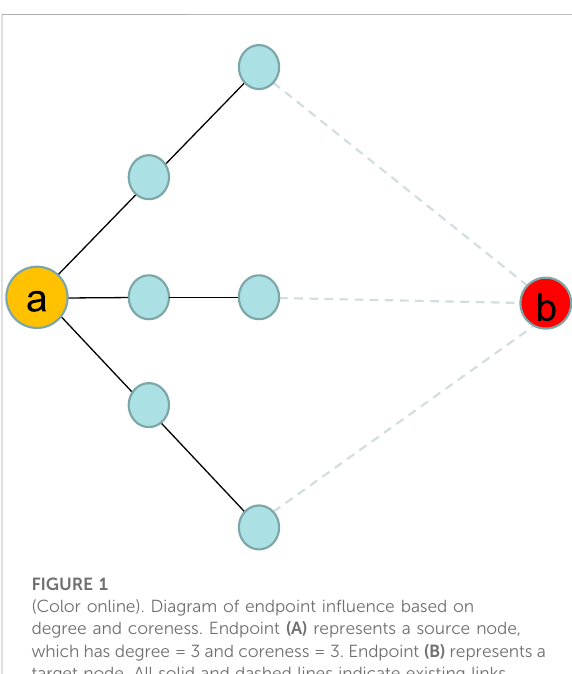
FIGURE 1 (Color online). Diagram of endpoint in fl uence based on degree and coreness. Endpoint (A) represents a source node, which has degree = 3 and coreness = 3. Endpoint (B) represents a target node. All solid and dashed lines indicate existing links and potential links,